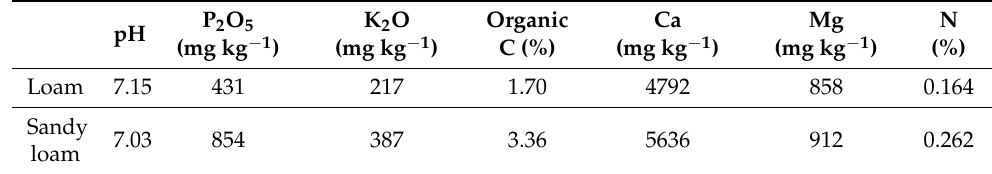
Table 1. Chemical composition of soil (0–20 cm layer) before fertilization.